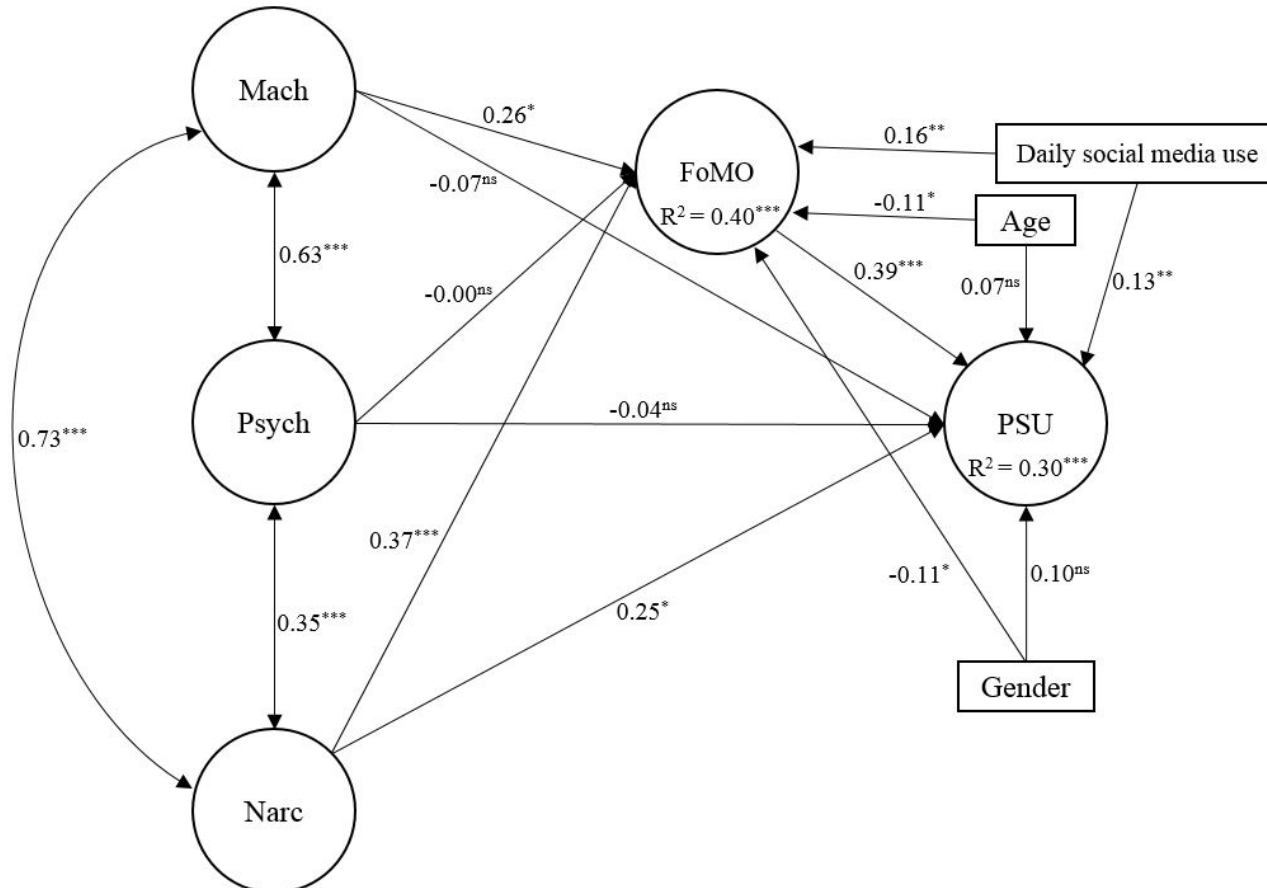
Figure 1. Results of the SEM analysis, including direct effects with respective standardized results and significance levels. Note . Mach = Machiavellianism; Psych = Psychopathy; Narc = Narcissism; FoMO = Fear of missing out; PSU = Problematic smartphone use. For clarity, item factor loadings, which were significant at p < 0.001, are omitted. * p < 0.05. ** p < 0.01. *** p < 0.001. ns = Non-significant.